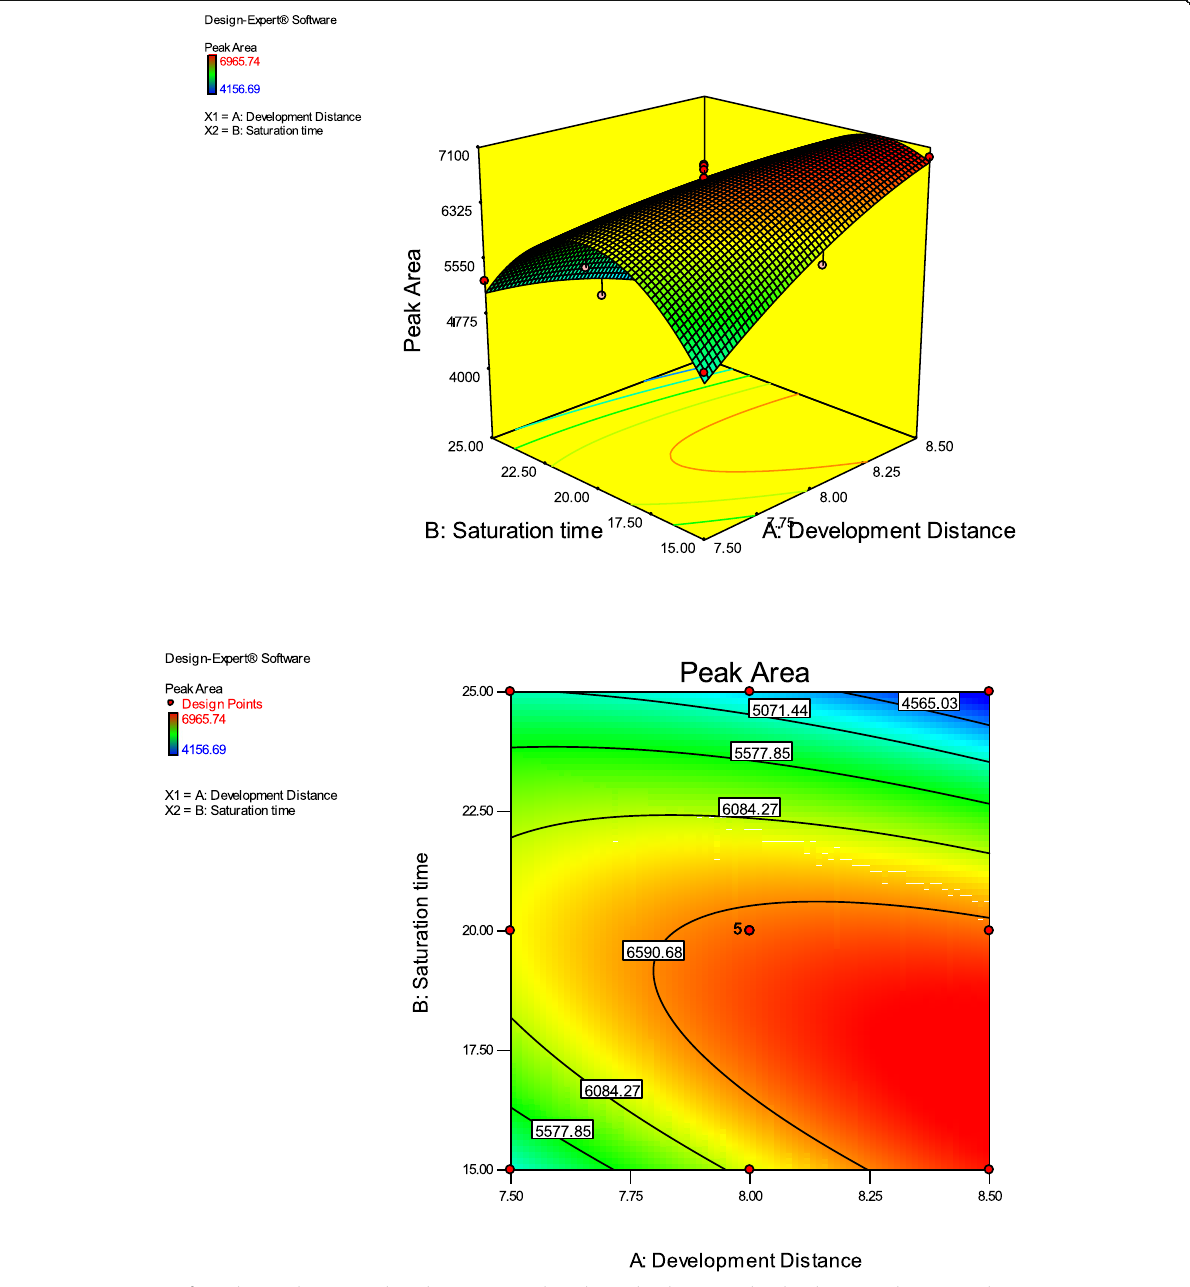
Fig. 3 3D response surface plots and counter plots demonstating the relationship between the development distance and saturation